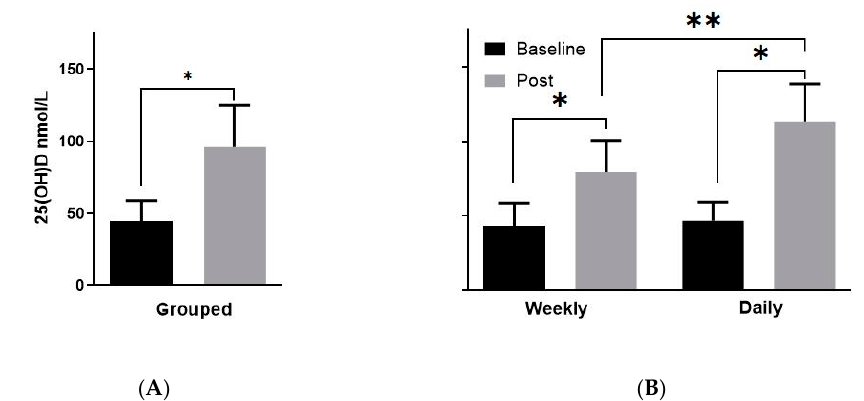
Figure 1. Vitamin D supplementation increased mean serum 25(OH)D concentration to above adequate levels >75 nmol/L (30 ng/mL). Women were sampled before and after 8 weeks of either weekly ( n = 10) or daily ( n = 10) high-dose vitamin D. ( A ) Grouped mean (± SD) serum 25(OH)D concentrations from both weekly and daily arms ( n = 20) before and after vitamin D supplementation. ( B ) Mean (± SD) serum 25(OH)D concentrations from weekly and daily supplementation arms. * Denotes significant di ff erence between baseline and treatment; ** denotes significant di ff erence between daily and weekly supplementation groups following